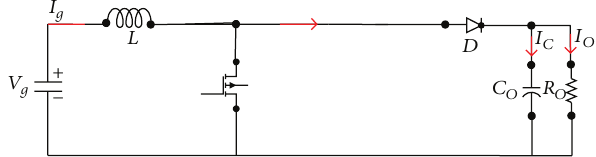
Figure 1: Circuit diagram of traditional boost